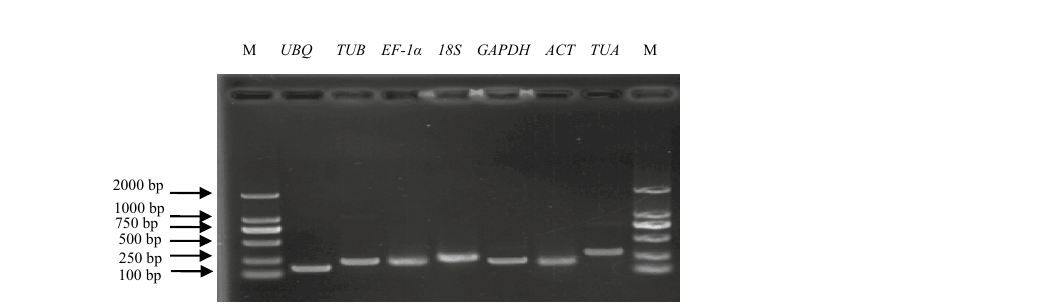
Figure 2. Agarose gel electrophoresis analysis of primer